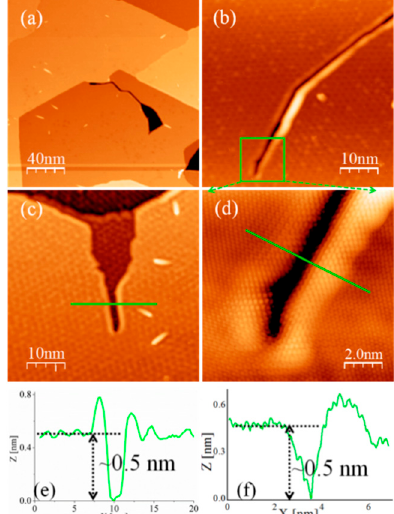
Figure 5. ( a , b ) The macro-morphology of EG with etched channels. ( c ) An enlarged image about one etched channel. ( d ) The atomic structure of the etched channel. ( e , f ) The height profiles acquired from the green lines in ( c , d ).